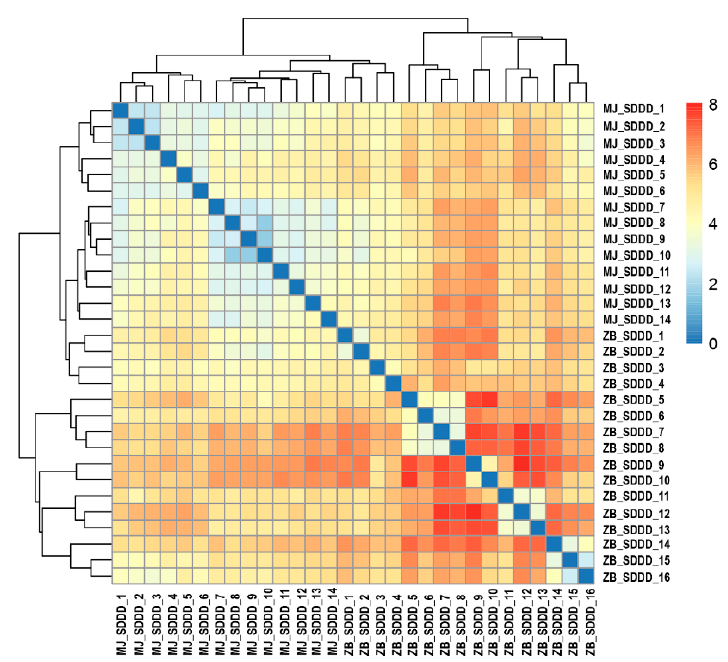
Figure 2. The distance matrix heatmap of 30 individuals of L. kasmira created using the R package poppr.